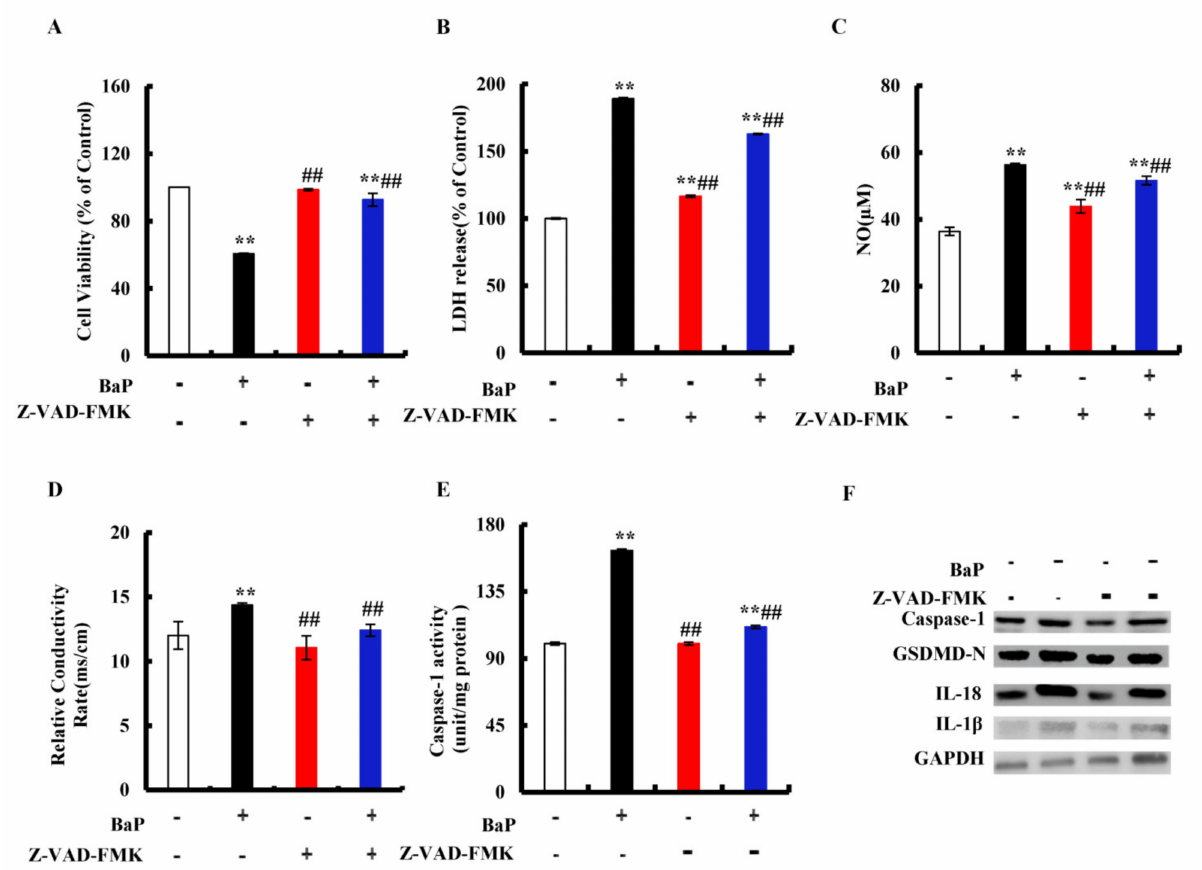
Figure 3. Effects of Caspase-1 inhibitor (Z-VAD-FMK, 20 µ M) on pyroptotic hepatocyte damage. Cell viability ( A ), LDH ( B ), NO ( C ), electrical conductivity ( D ), and Caspase-1 enzyme activity ( E ) were detected. ** p < 0.01 compared with control, ## p < 0.01 compared with 25 µ M BaP. Western blot image of protein expression acquired by Chemical XRS Imaging System ( F